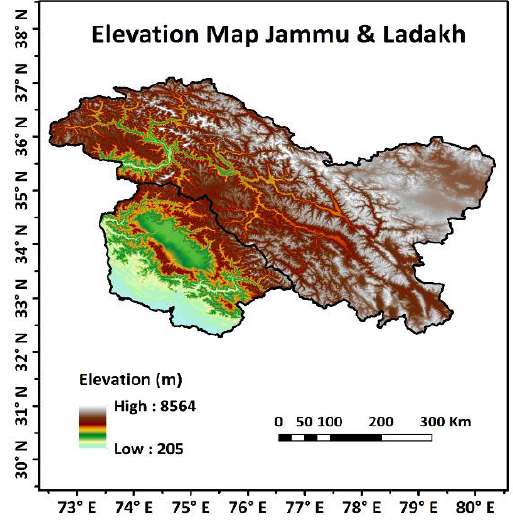
Figure 2 . The elevation map of Jammu-Kashmir and Ladakh. experiences high temperate and cold desert temperature. The states have a large amount of biomass by-products that can be used to generate electricity using solar energy, biogas, gasification technology, and other methods. The Ladakh region receives roughly 320 days of sunshine per year, making it one of the top solar cooking locations in the world. The technologies such as solar thermal systems, which include solar driers, solar water heaters, stream and dish colours, solar green houses, and other renewable energy technology, have been encouraged in the state.